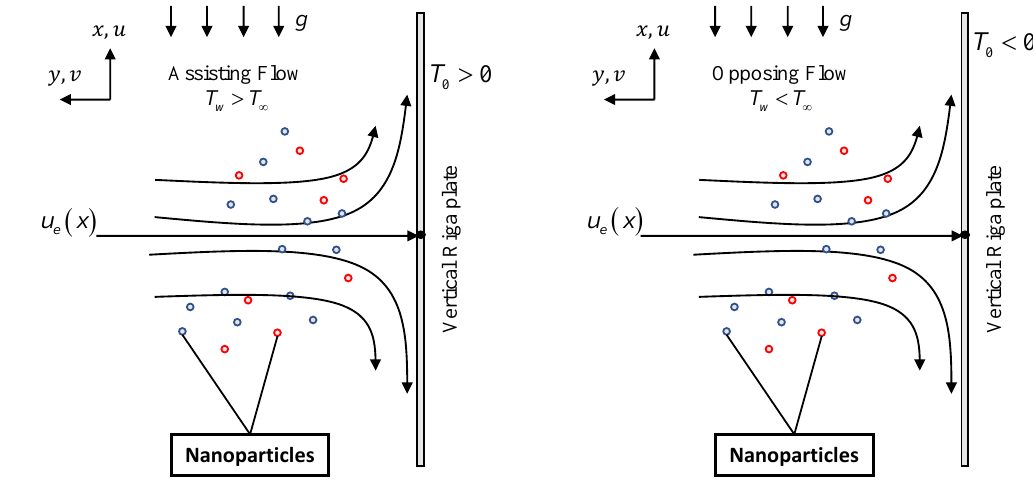
Figure 2. The geometry of the governing model for assisting flow and opposing